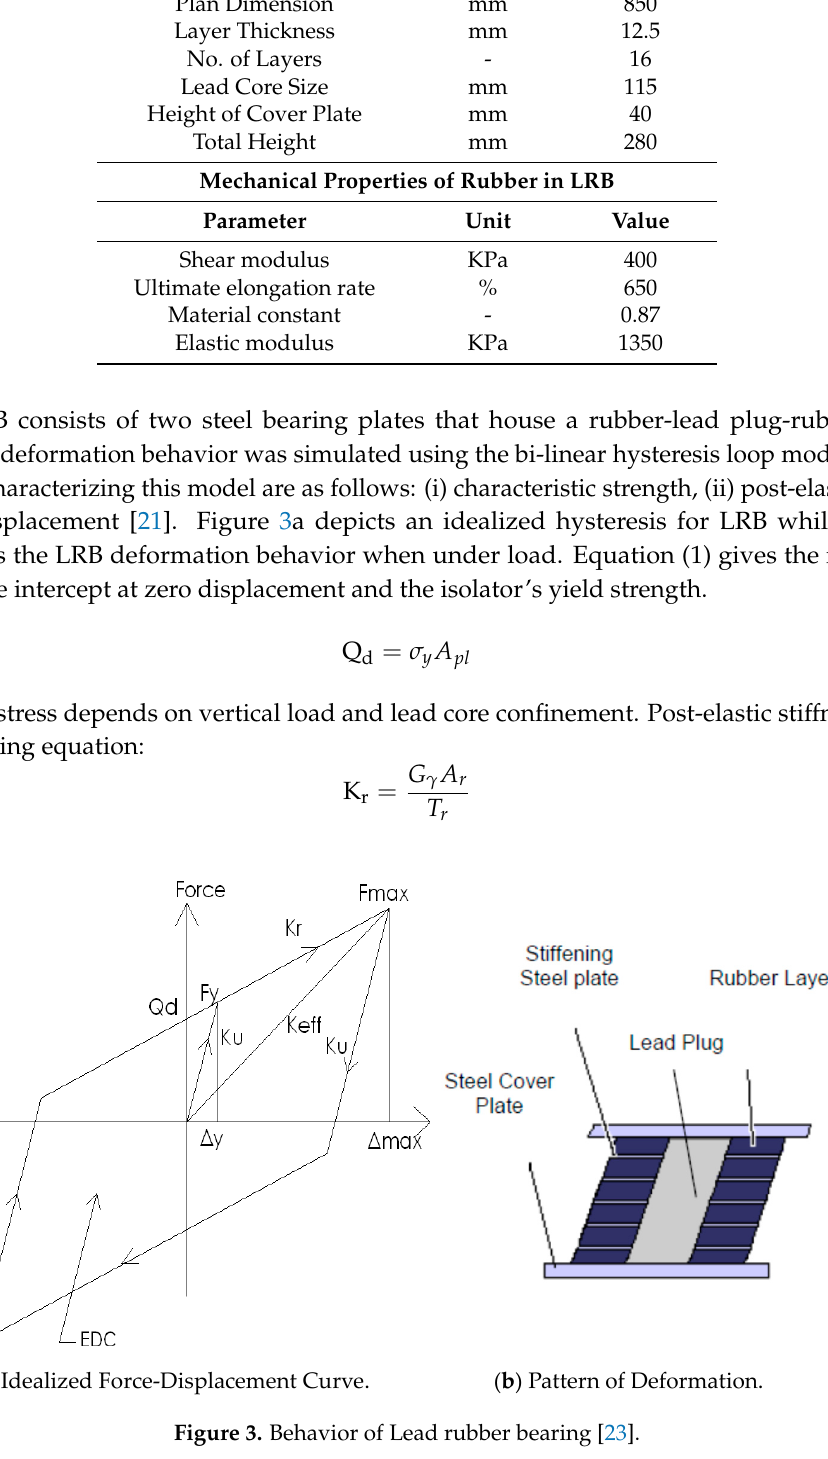
Table 3. Selected LRB system properties.